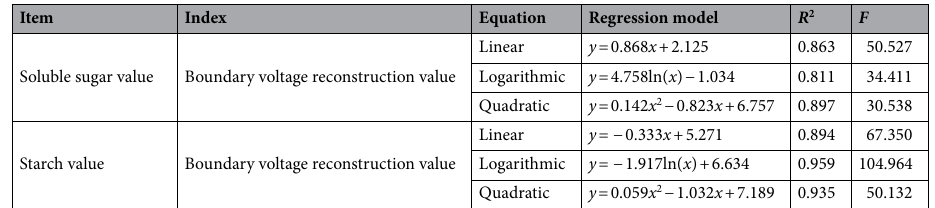
Table 1. Analysis of the regression for soluble sugar and starch contents as functions of reconstructed electrical impedance tomography (EIT) boundary voltage values.